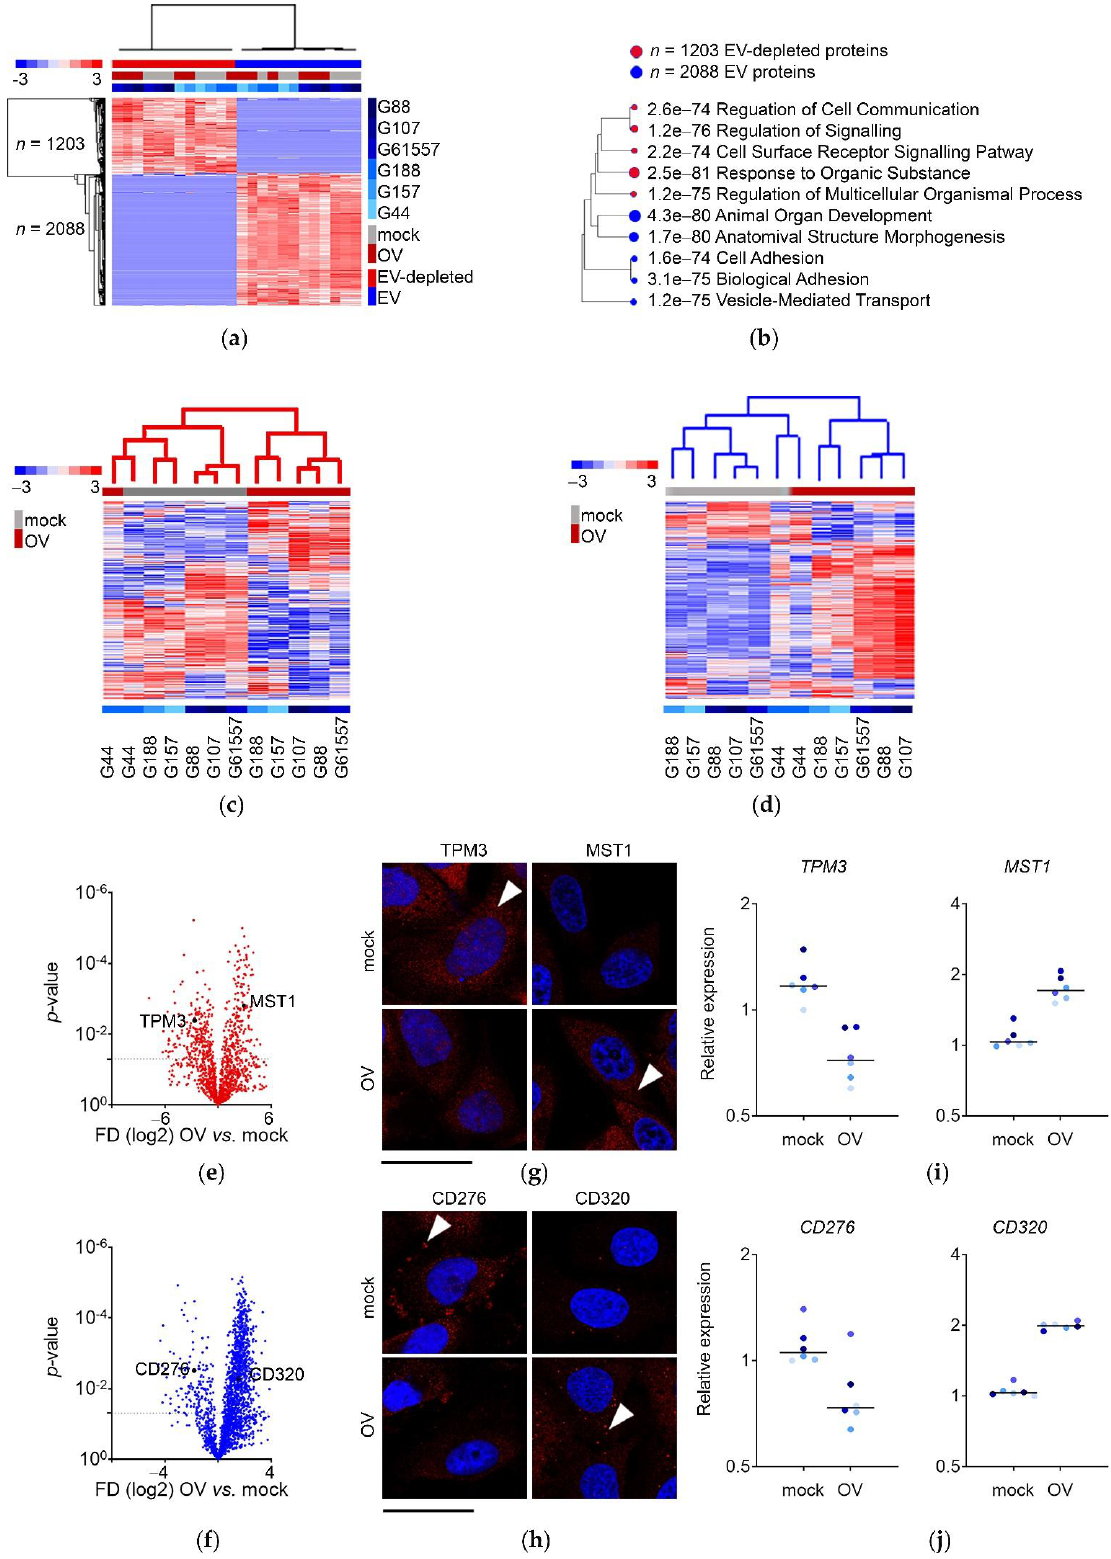
Figure 3. Proteins secreted by mock- and OV-infected GSCs ended up in non-overlapping EV-depleted and EV fractions. ( a ) The composition of EV-depleted and EV fractions of the secretome was distinctly dissimilar. Heatmap with unsupervised hierarchical clustering for GSCs mock or OV infected ( n = 6 per variant) based on mass spectroscopy analysis in EV-depleted and EV fractions ( n = 3291 proteins (1203 EV-depleted and 2088 EV)). ( b ) Proteins secreted EV-depleted and